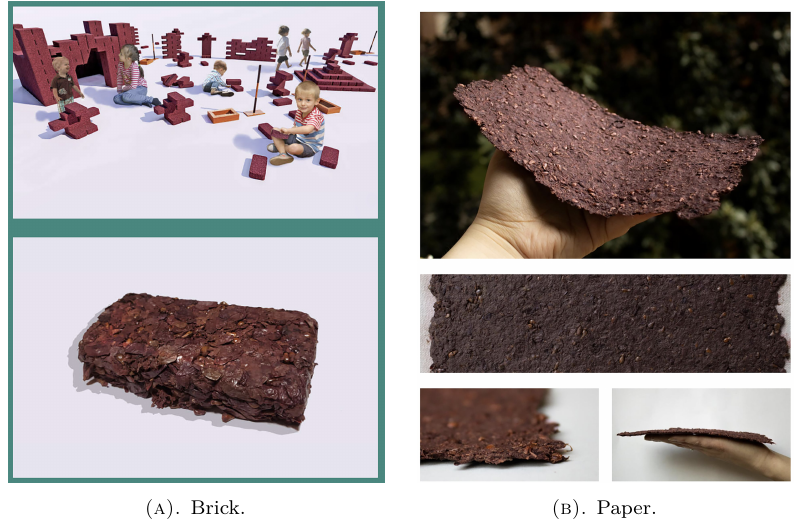
Figure 2. Examples of pomace